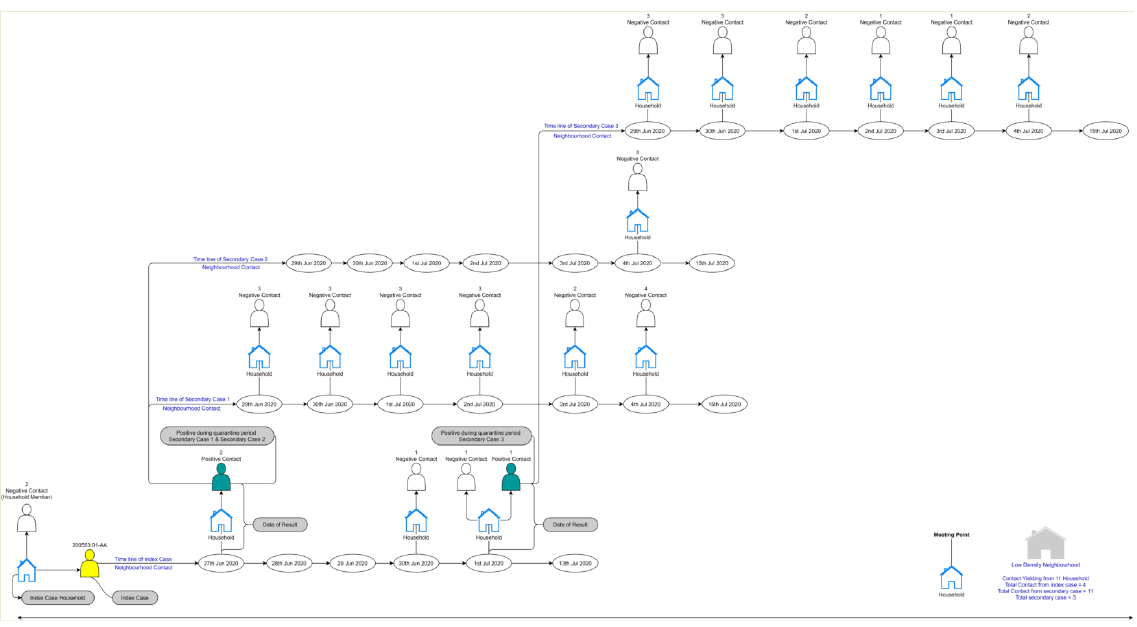
Figure A1. Diagram showing the setting of exposure and the direction of transmission from index case to household and neighborhood contacts in high-density areas in Dhaka city.